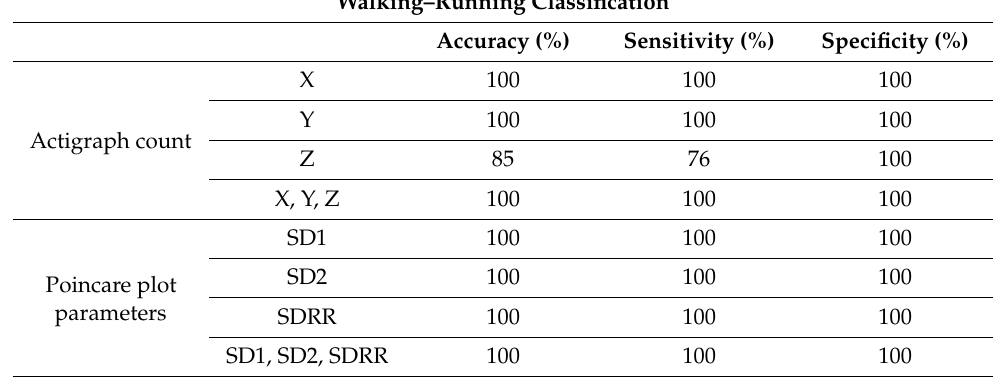
Table 2. Accuracy with count- and angle variance (Poincare plot)-based classification for the MHealth (walk–run)